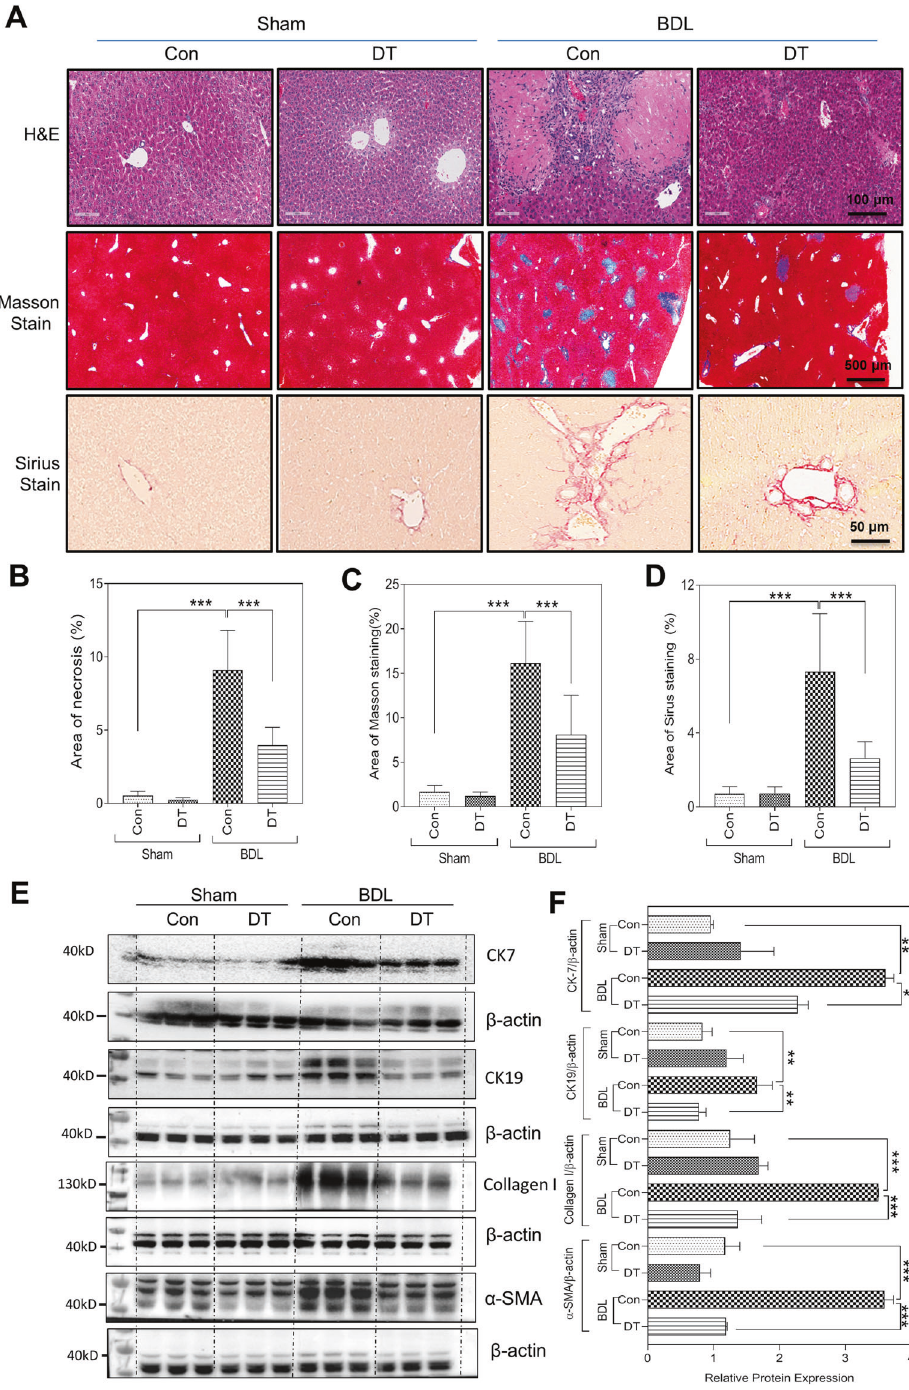
Fig. 3 Macrophage depletion inhibits BDL-induced liver fi brosis and cholangiocyte proliferation. A Representative images of H&E staining, scale bars: 100 μ m; Masson ’ s trichrome staining, scale bars: 500 μ m; and Sirius Red staining scale bars: 50 μ m for livers of Sham, Sham + DT, BDL, and BDL + DT mice ( n = 5 – 8). B – D Quanti fi cation of necrosis area, Masson area, and Sirius area in panel A by ImageJ. E Western blotting analysis for CK7, CK19, collagen type I, and α -SMA in Sham, Sham + DT, BDL, and BDL + DT mice. Representative images of the immune blottings are shown. F Quanti fi cation of panel E . Data were expressed as mean ± SD from fi ve to eight mice per group. * P < 0.05, ** P < 0.01, *** P < 0.001.